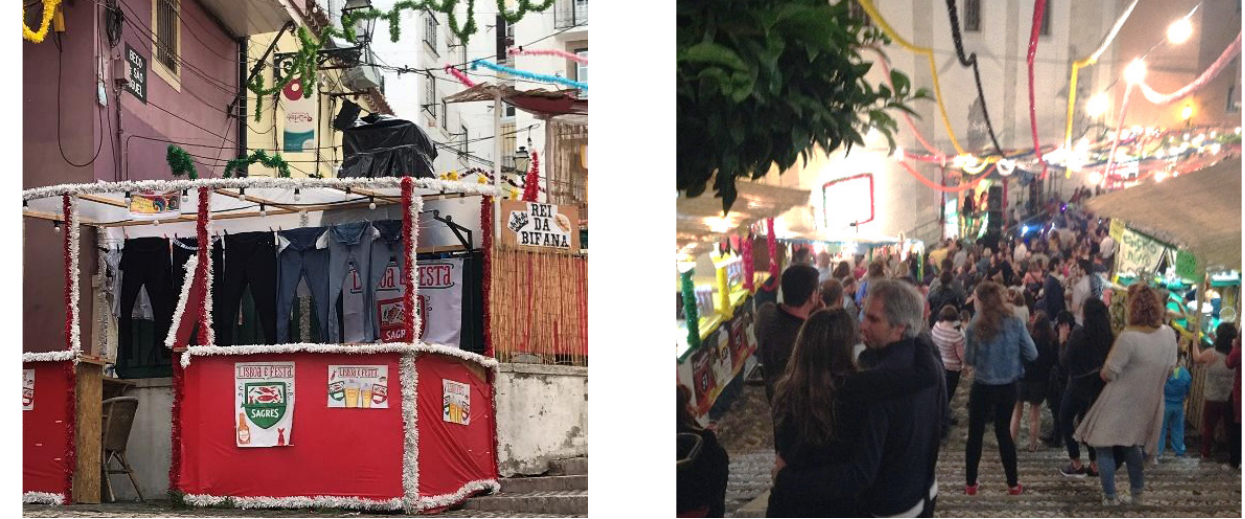
Figure 7. Escadinhas de São Miguel, Alfama, June 2019. Figure 8. Escadinhas de São Miguel, Alfama, June